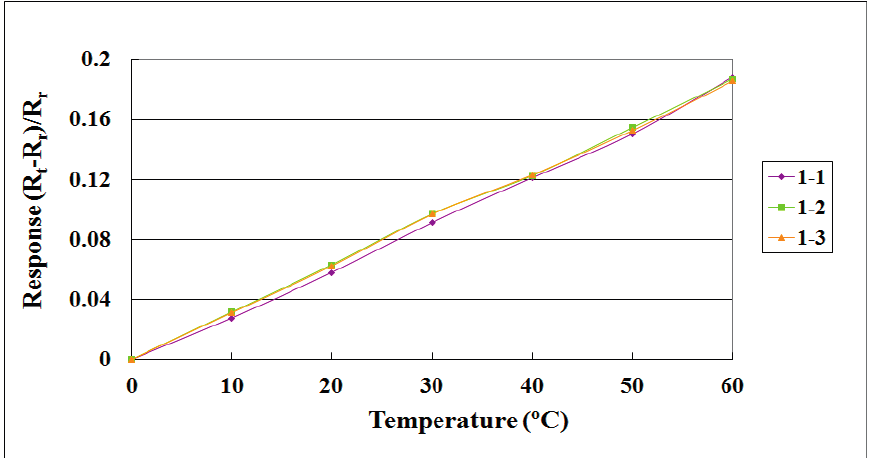
Figure 5. Correction curve of a temperature microsensor (sensor 1).